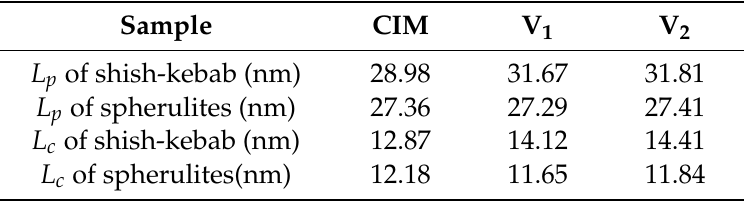
Table 3. Value of long period and crystalline size of di ff erent layers of